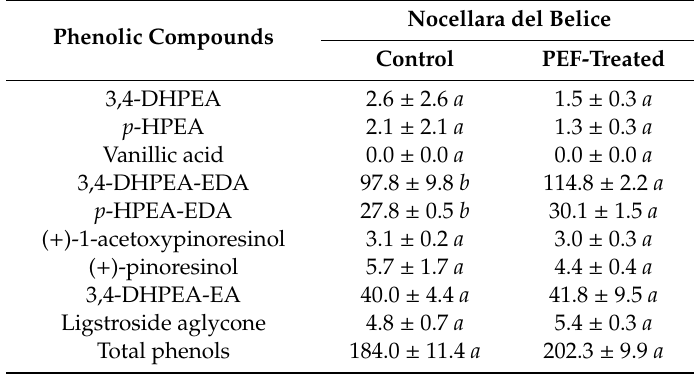
Table 3. Phenolic composition of EVOOs (mg / kg).